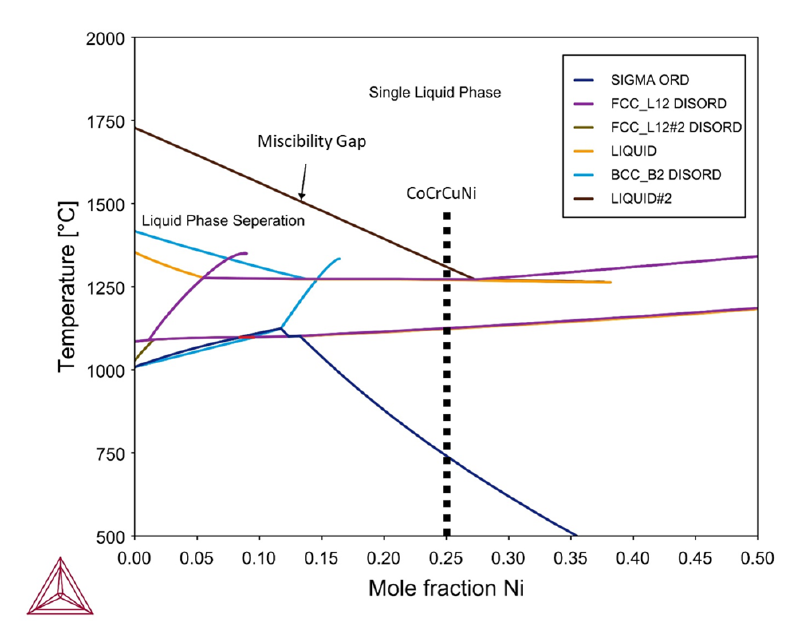
Figure 9. Calculated isopleth of the CoCrCuNi x system using Thermo-Calc software. Legend descriptions: SIGMA ORD = ordered σ phase, FCC L12 DISORD = disordered FCC phases, BCC B2 DISORD = disordered BCC